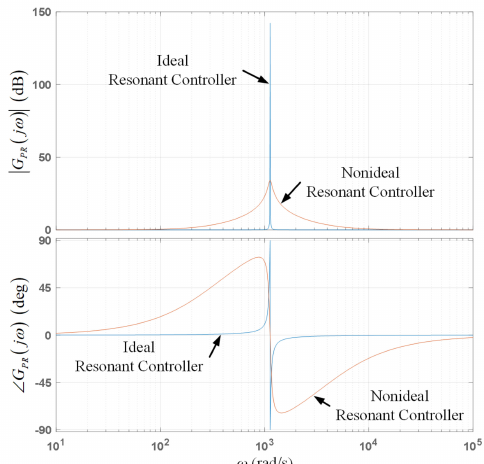
Figure 4. Bode plot of ideal and nonideal PR